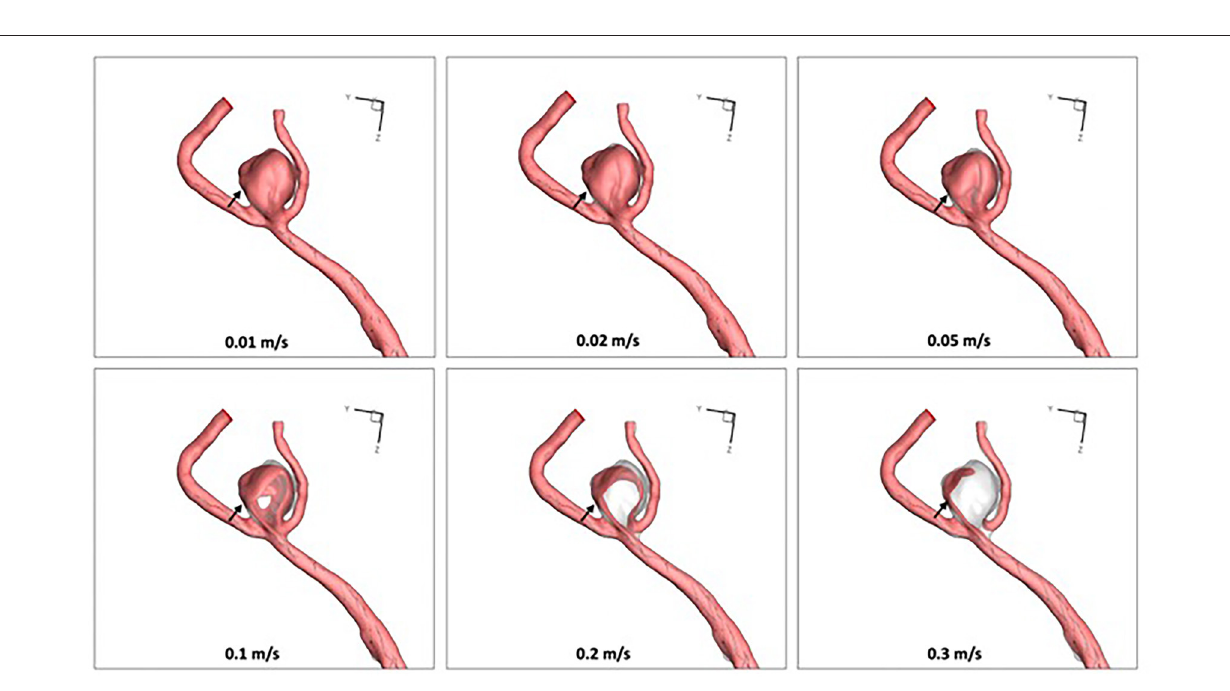
FIGURE 3 | As the threshold velocity value increased in the virtual stenting with parent artery straigtening (Model IV), the high flow region (0.3 m/s) focused on the inflow trunk of the aneurysm neck